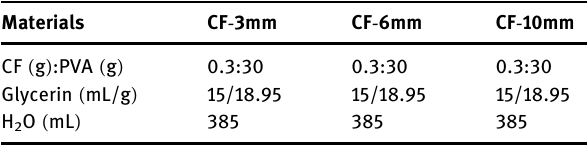
Table 2: Mixture ratio for fabrication of fi lms with CF of